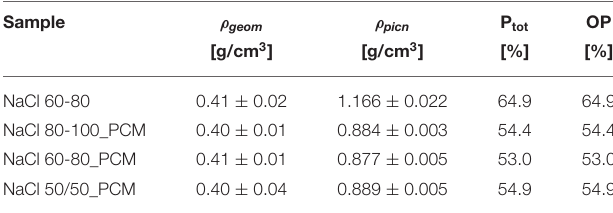
TABLE 1 | Density and porosity values of the prepared ethylene-propylene diene monomer (EPDM) and thermal energy storage- (TES-) EPDM foams. Sample ρ geom ρ